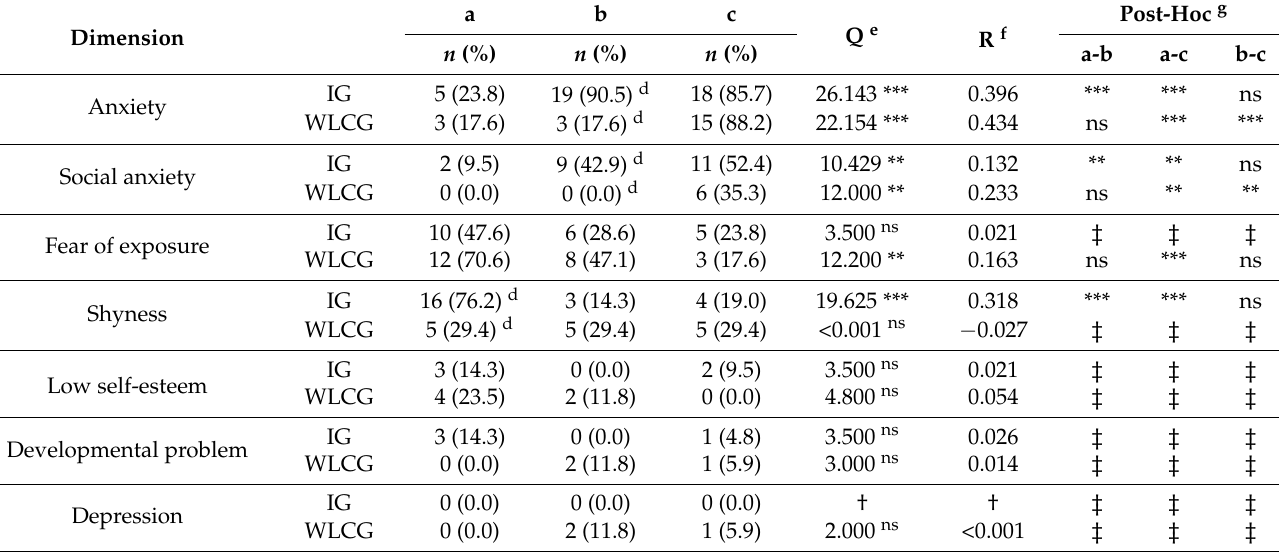
(a) First assessment; (b) second assessment; (c) third assessment; d significance associated with the Chi-Square test ( χ 2 ) between group and dimension; e comparison with Cochran’s Q test (Q); f chance-corrected measures of effect size (R); g post-hoc procedures with Dunn’s test, adjusted with Bonferroni’s significance correction; ** p < 0.01; *** p < 0.001; ns = not significant; † test not performed or measure not calculated; ‡ post-hoc procedure not